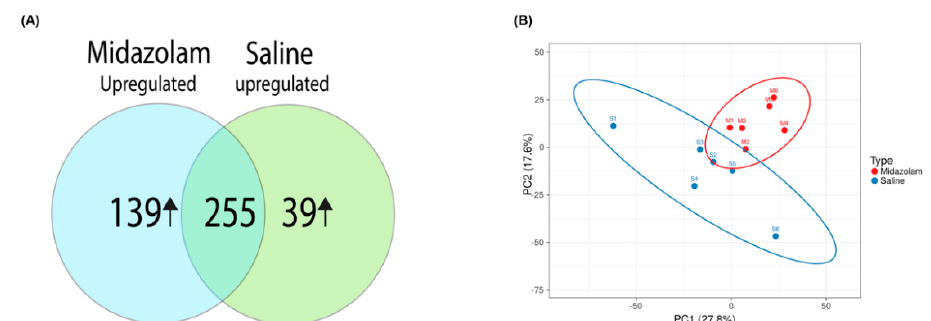
Figure 1. Overall data differentiation between control and MDZ-exposure samples: ( A ) Venn diagram showing total differentially expressed proteins found in between samples; the ↑ symbol represents the upregulation of DEPs with respect to saline or MDZ group. ( B ) principal component analysis (PCA) between the saline and midazolam-exposed samples from all six biological replicates from each group.